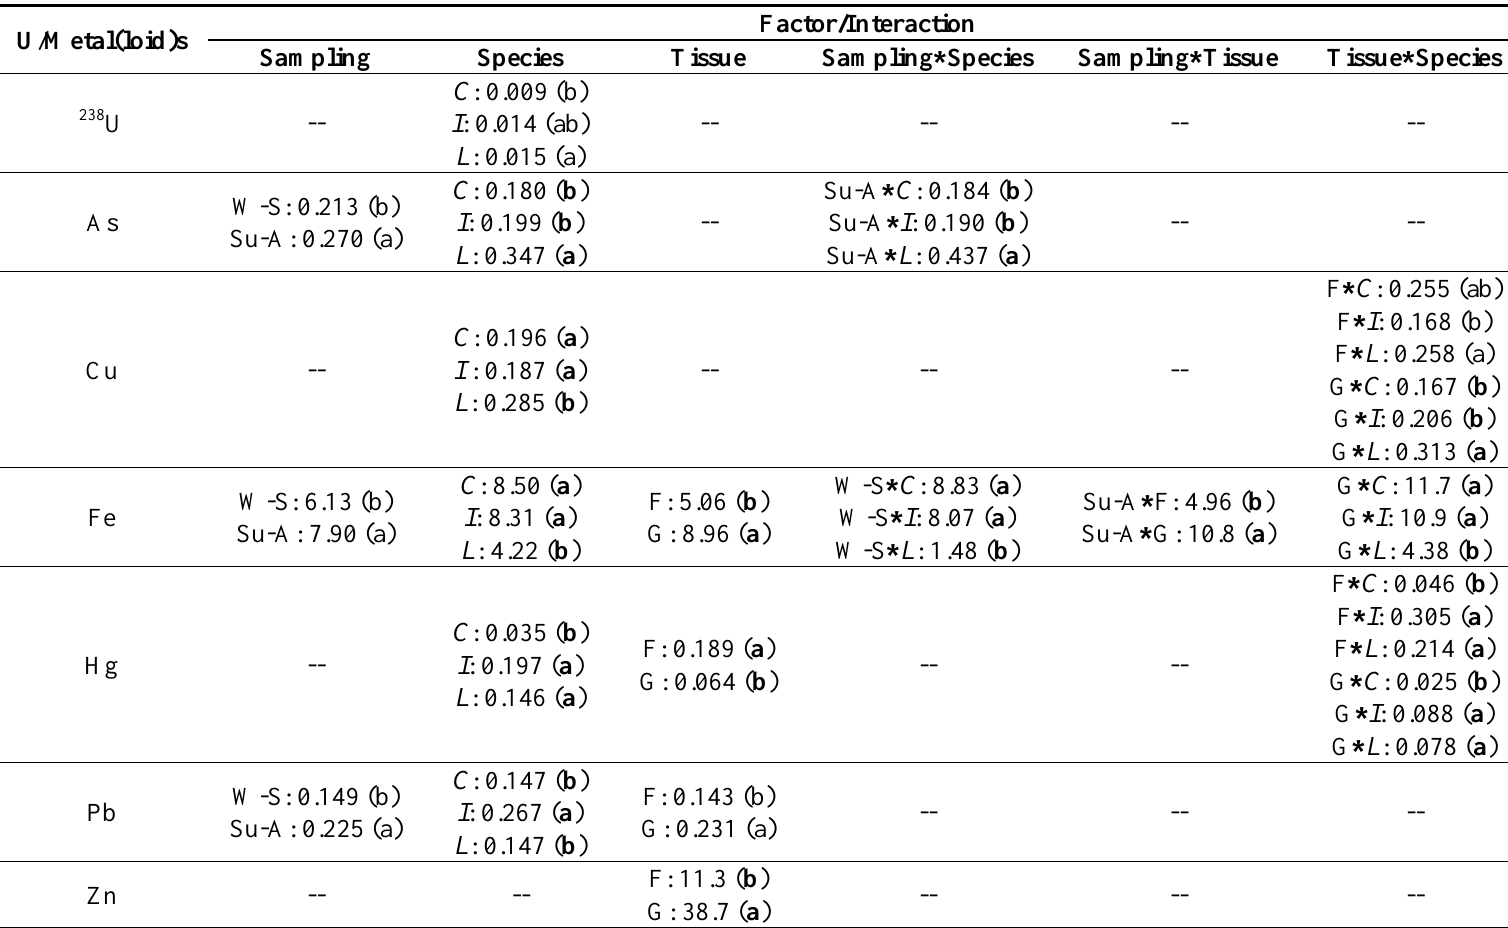
Table A3. Arithmetic means of uranium (Bq∙kg −1 ww) and metal(loid) concentrations (mg∙kg −1 ww) with probability values from factors and theirs interaction with significant differences (MANOVA, p < 0.05) in fish sampled at Luis L. Leon